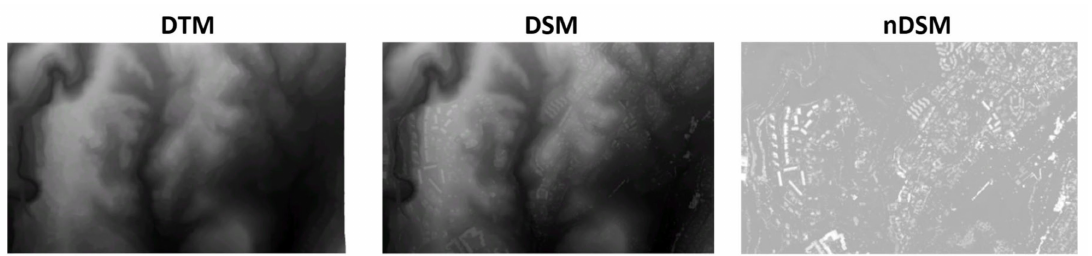
Figure 2. Digital elevation models (DTM, DSM, and nDSM).